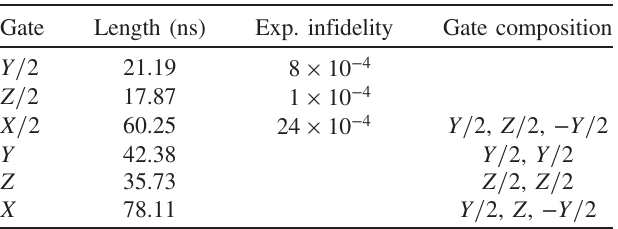
TABLE I. Clifford gates.